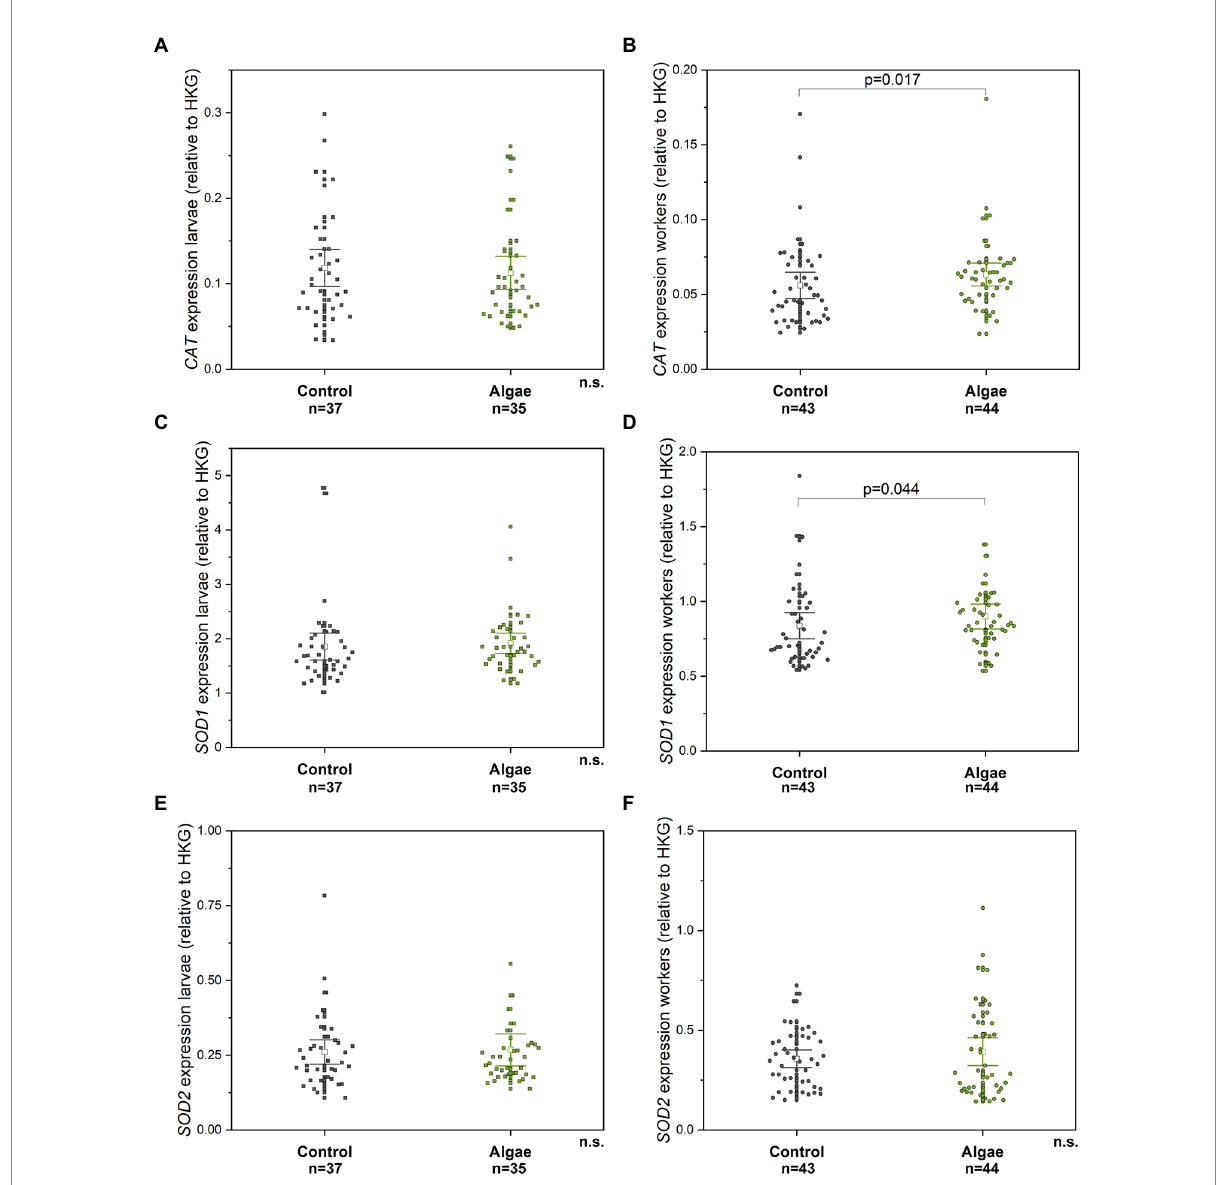
FIGURE 3 The relative gene expression of CAT , SOD1 , and SOD2 compared to HKG in larvae (A, C, E) and adult workers (B, D, F) , respectively. n. s. – non- significant difference. Control – bees from colonies fed with APIVITAL® sugar syrup. Algae – bees from colonies fed with 10% (w/v) Chlorella powder in APIVITAL® sugar syrup. HKG – housekeeping